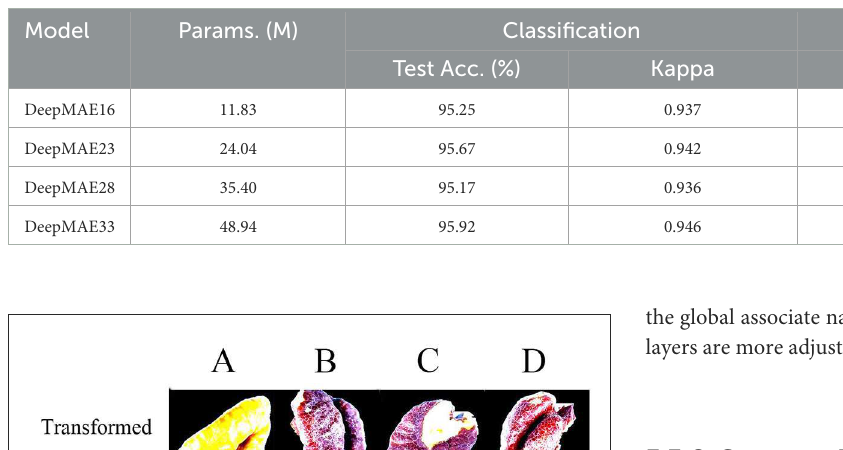
TABLE 4 Comparison of “classification only” and “classification and feature reconstruction” on four DEEPMAEs.